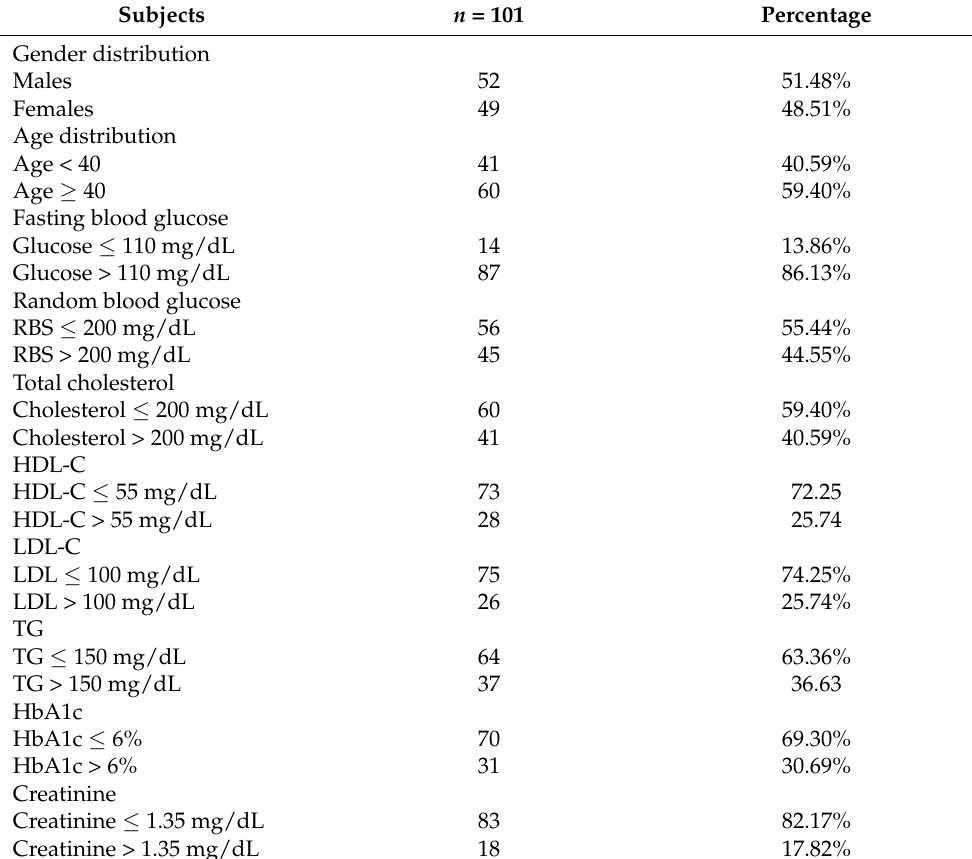
Table 2. Demographic features and baseline characteristics of T2DM patients.